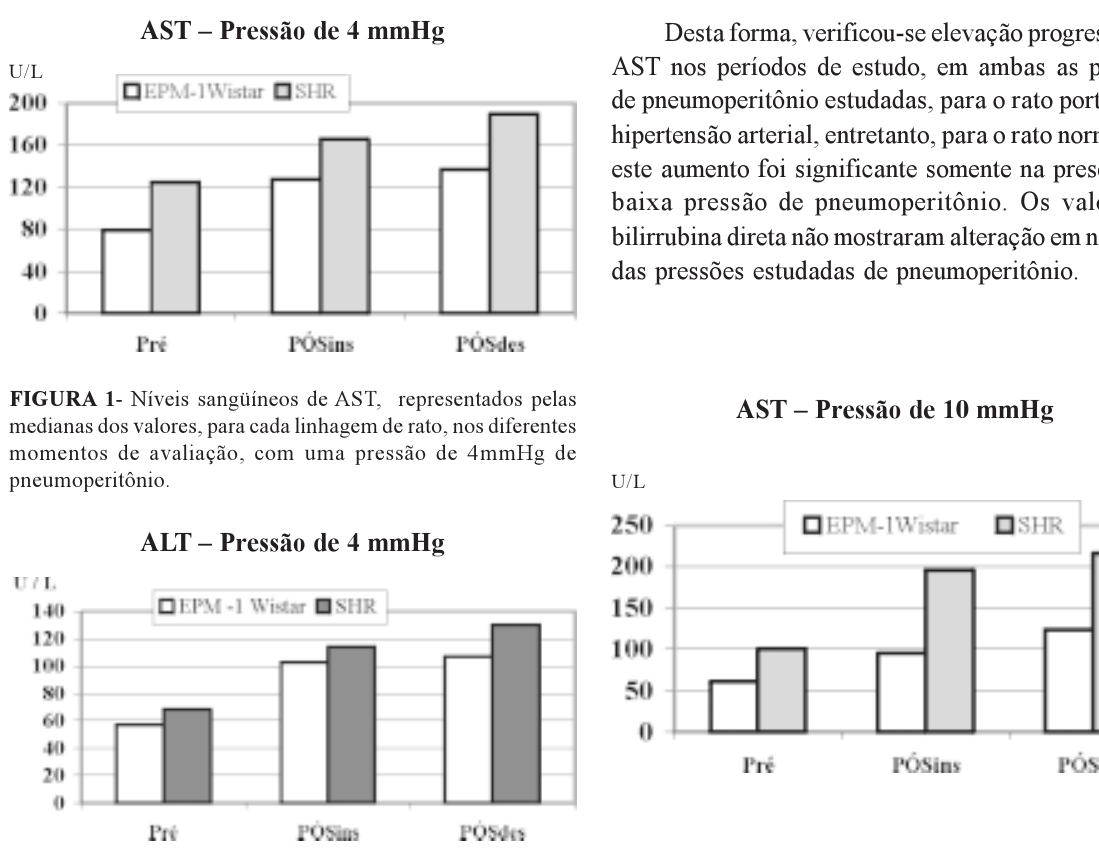
FIGURA 2 - N(cid:237)veis sang(cid:252)(cid:237)neos de ALT, representados pelas medianas dos valores, para cada linhagem de rato, nos diferentes momentos de avalia(cid:231)ªo, com uma pressªo de 4mmHg de pneumoperit(cid:244)nio. 54 - Acta Cirœrgica Brasileira - Vol 18 (1) 2003